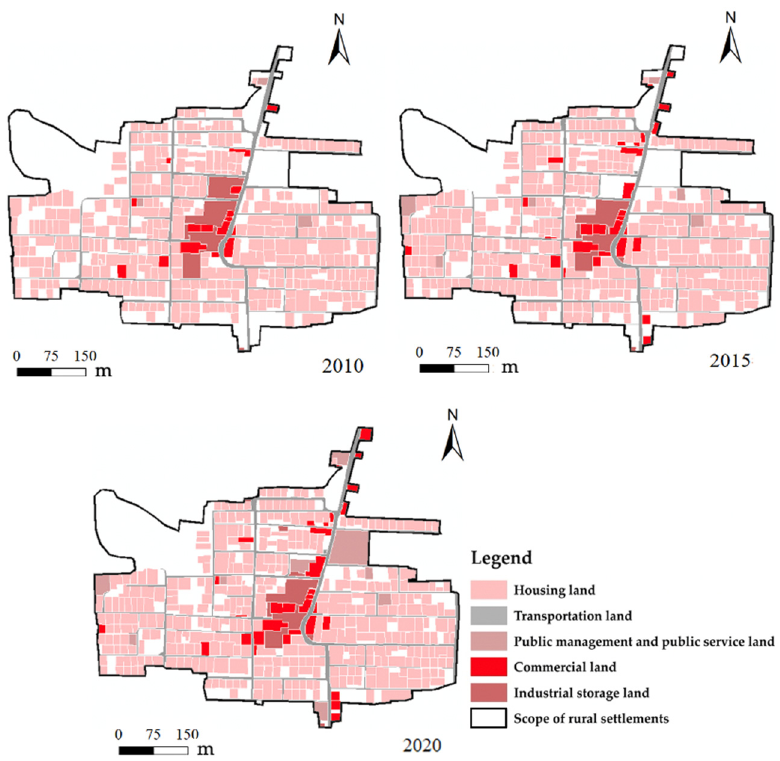
Figure 5. The evolution of rural residential land in Jiling Village from 2010 to 2020.